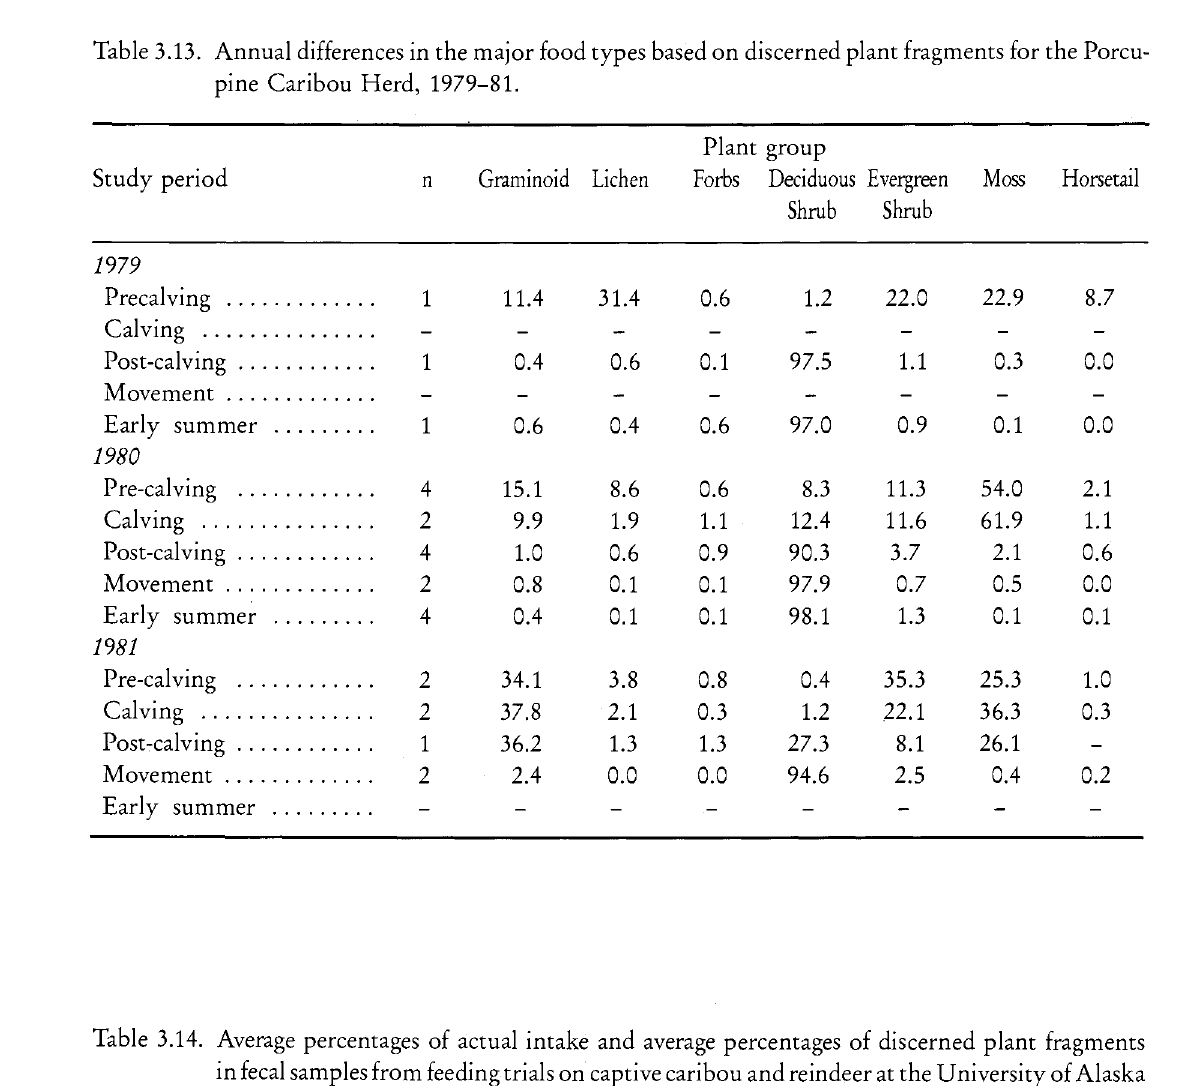
Table 3.13. Annual differences in the major food types based on discerned plant fragments for the Porcu pine Caribou Herd, 1979-81.